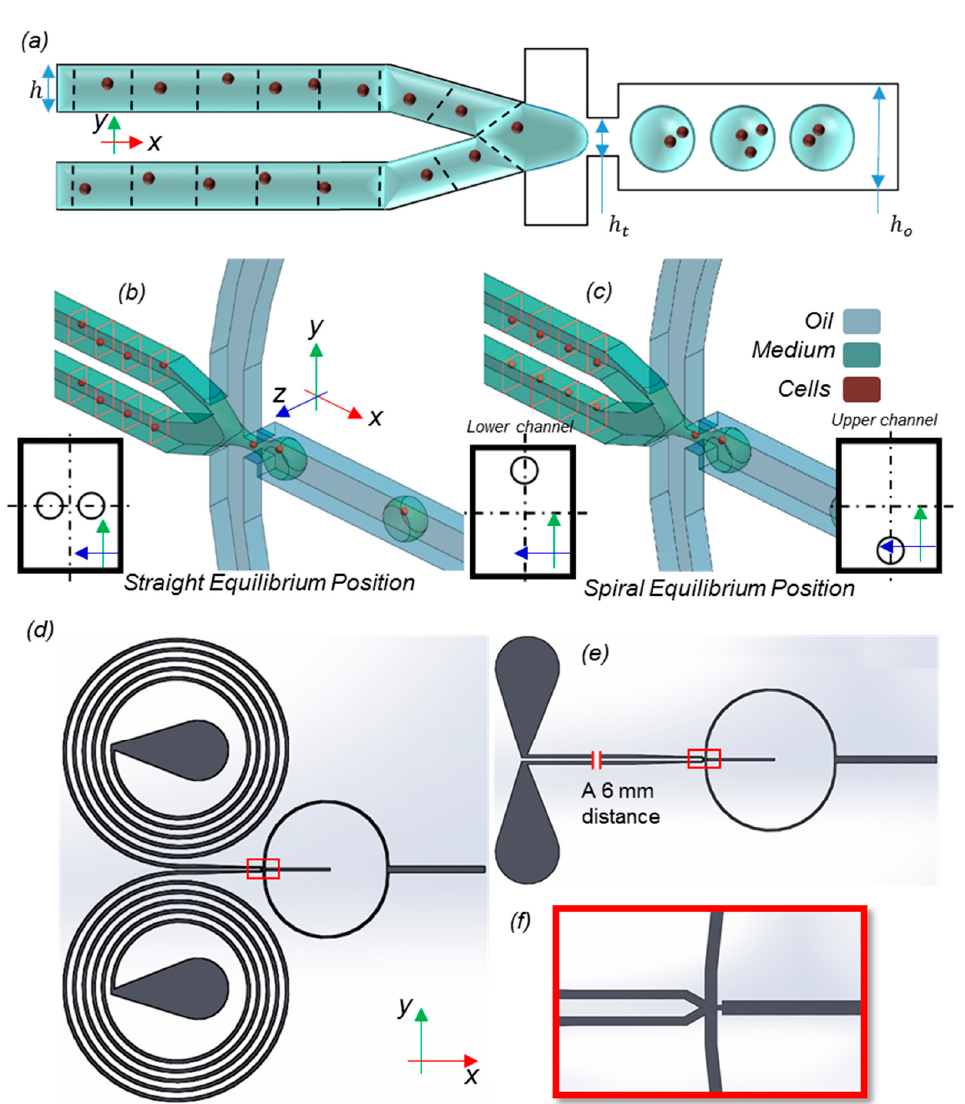
Figure 1. ( a ) Model and dimensions. Inertial focusing devices are used to control the injection of particles into the computational domain. ( b , c ) The lateral equilibrium locations of the particles in straight and spiral flow-focusing devices, respectively. In spiral microchannels with specific aspect ratios and particle densities, the equilibrium location of the particles changes to near the outer side of the spiral. The rectangular red frames show the cross-sections in which particles lie to better emphasize their local positions. ( d ) Microchannels with spiral and ( e ) straight flow-focusing devices. The magnified part ( f ) shows the droplet formation junction, which is separated with a red rectangular frame in ( d ) and ( e ).